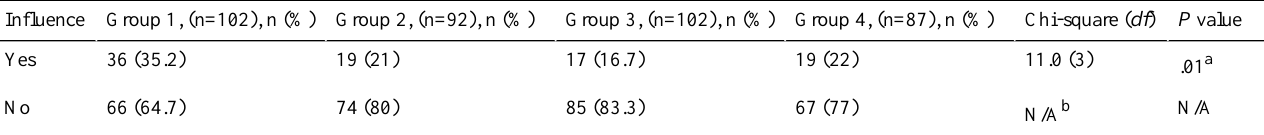
Table 3. Participants’perceptions of whether they were influenced by the anchor that they were exposed